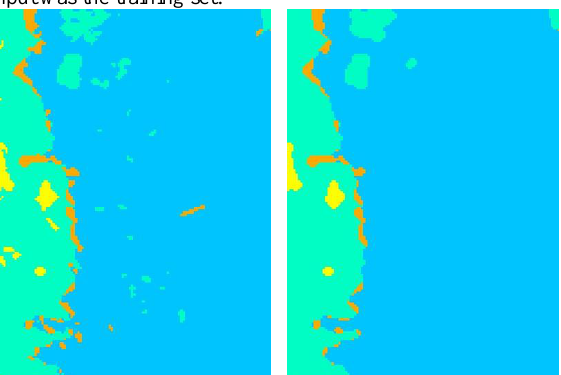
Figure 4 . Comparison of Majority filter use